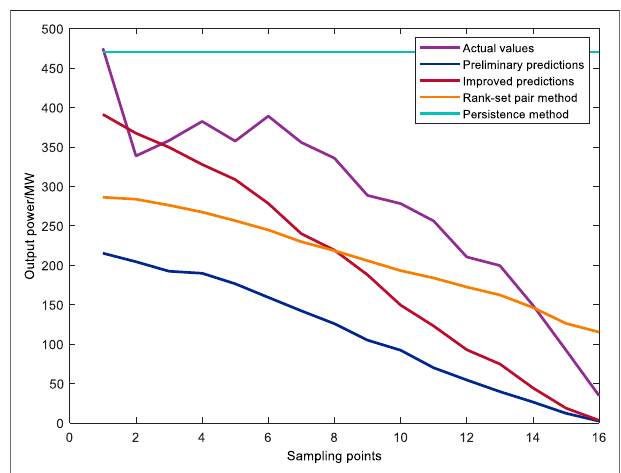
FIGURE 17 | Comparison of predictions for the afternoon phase yielded by different